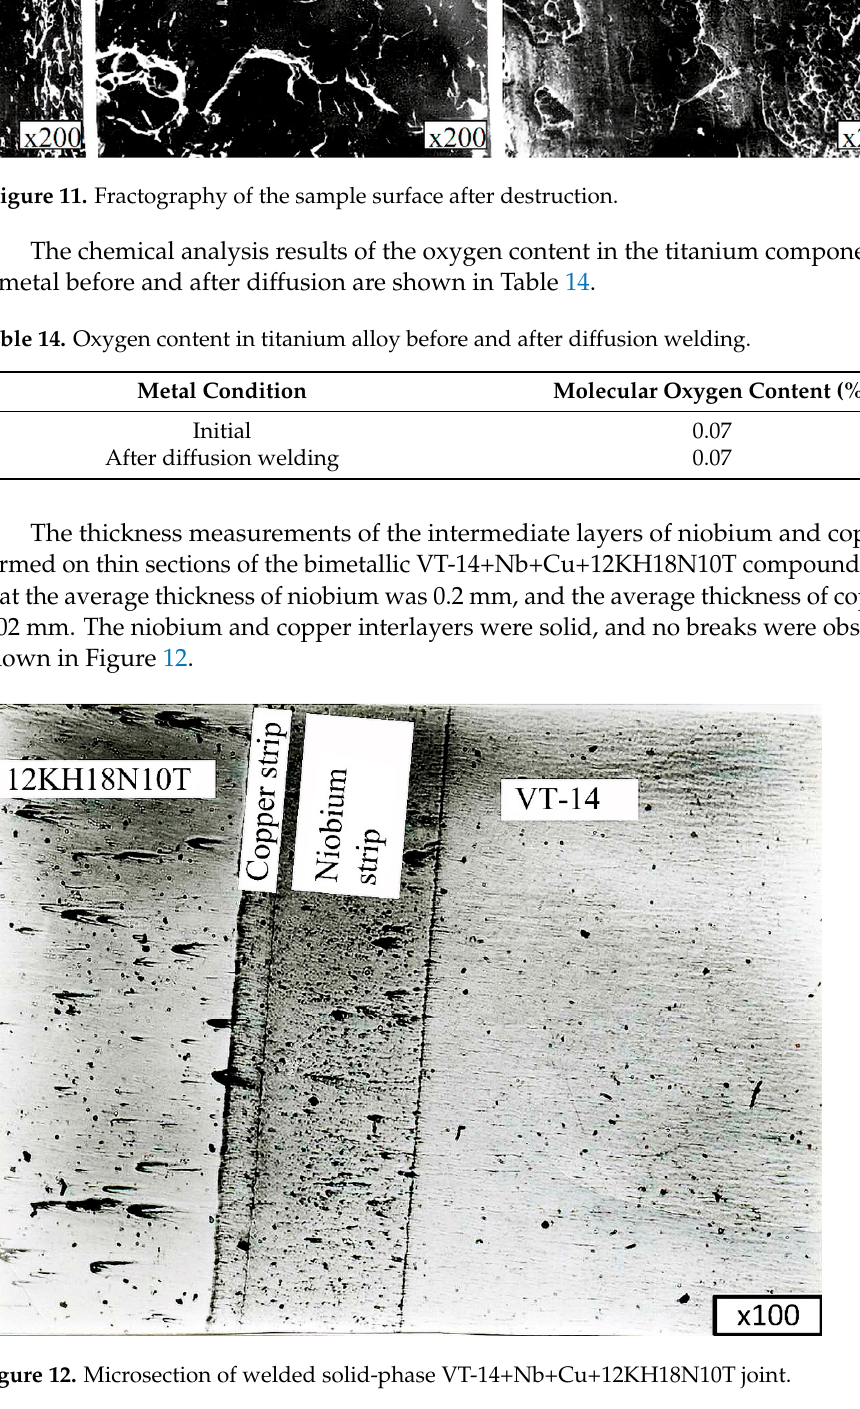
Figure 10. View of the destroyed sample after testing.